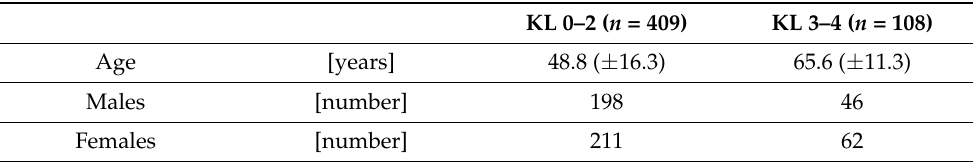
Table 1. Characteristics of the study population ( n = 517) divided up into patients without (KL 0–2; n = 409) and with osteoarthritis (KL 3–4; n = 108).